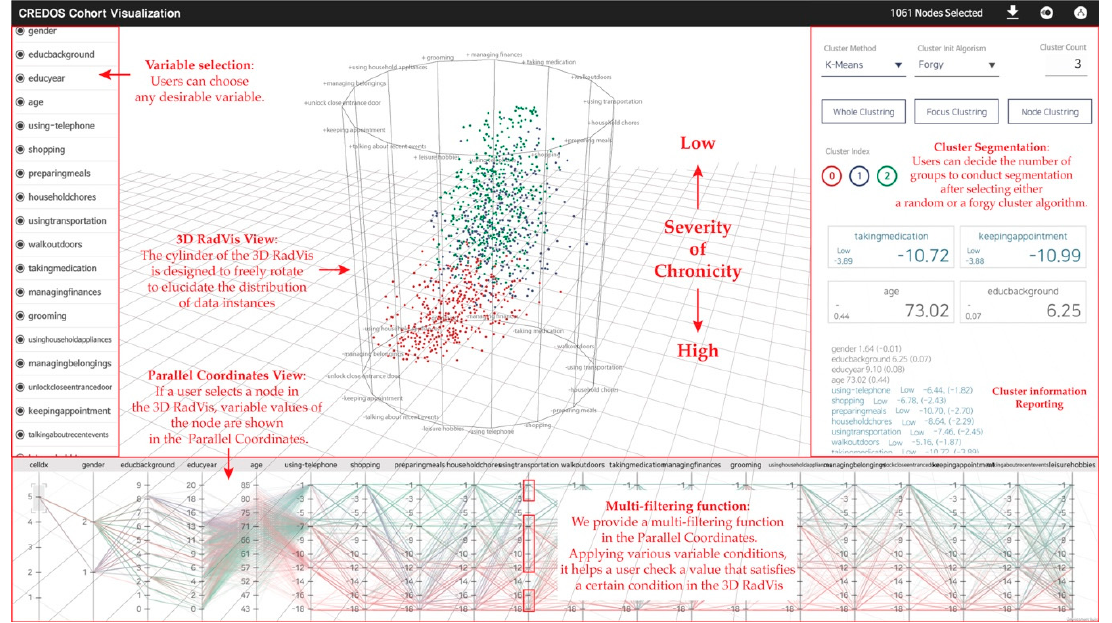
Figure 5. Visualization combining 3D RadVis and Parallel Coordinates.